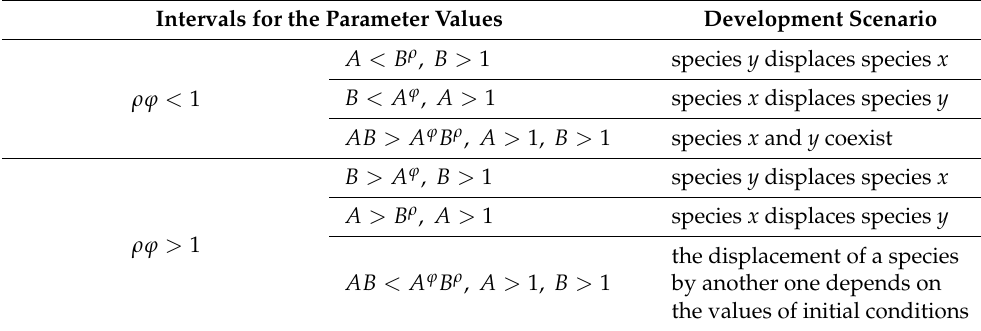
Table 1. Development scenarios of competing populations depending on the parameter